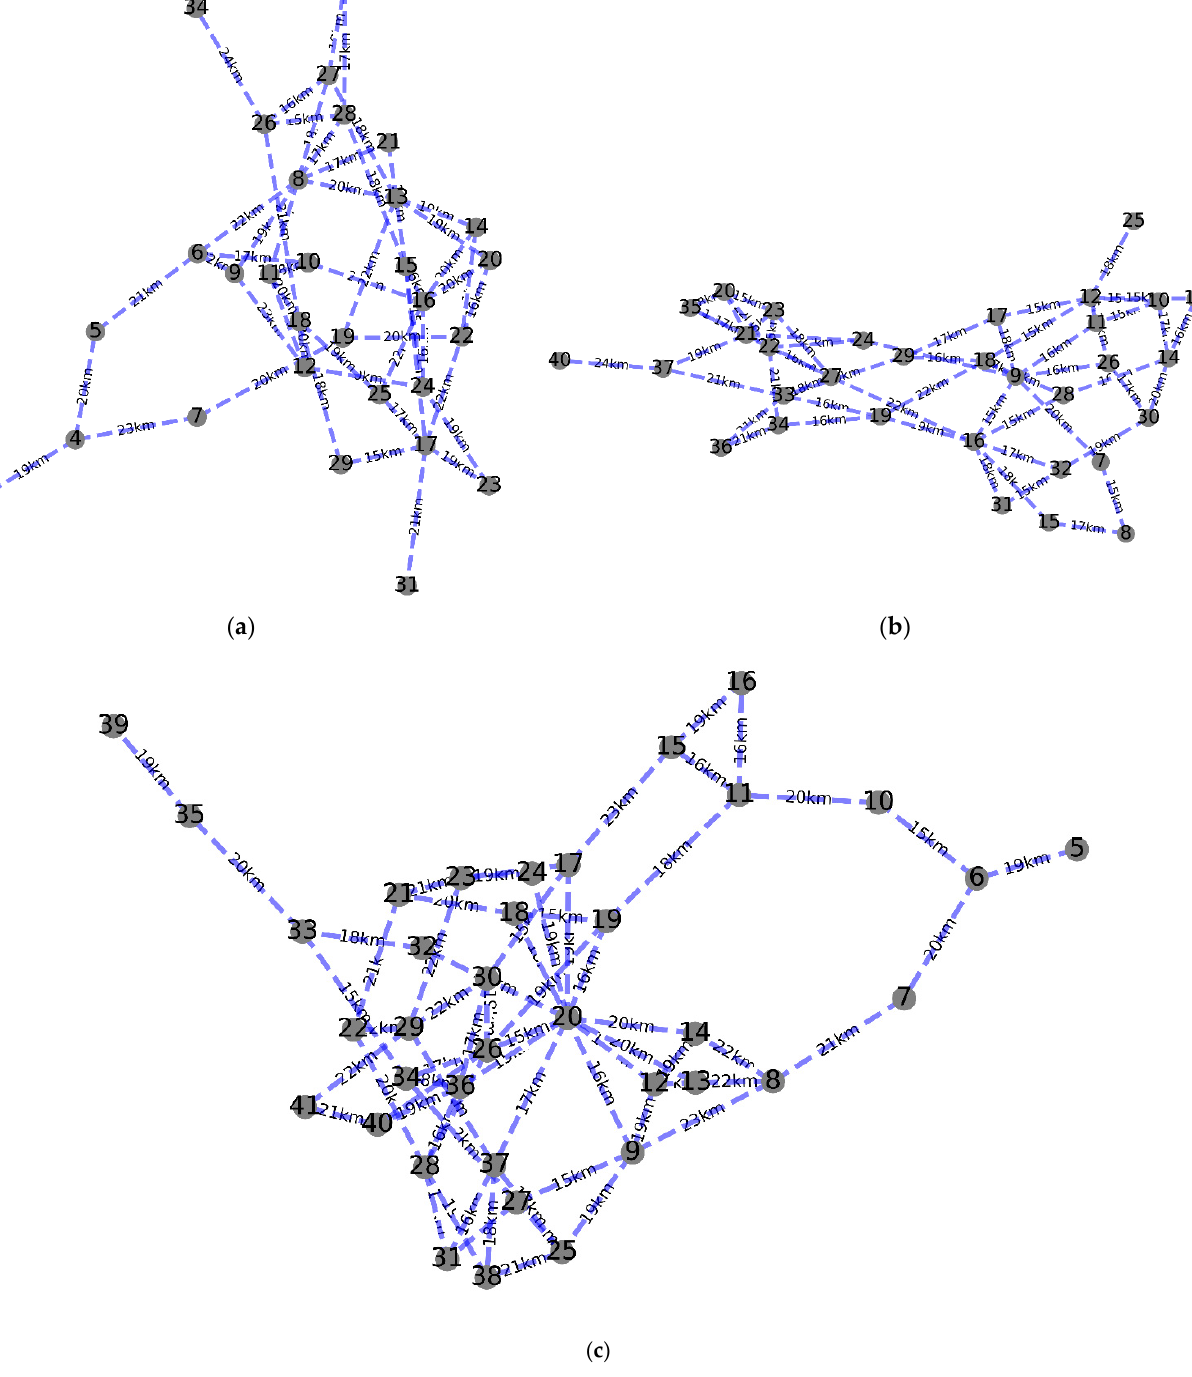
Figure 9. Node Link Network Representation of EVCS for ( a ) 23 °C, ( b ) − 3 °C, and ( c ) 49 °C. Node-link networks, according to Equations (6) and (8), provide nodes equal to or less than the total output of GA if the distance between the disqualified node and the nearest node is larger than the detour. However, the eliminated nodes will be plotted on the interactive maps of Leaflet and